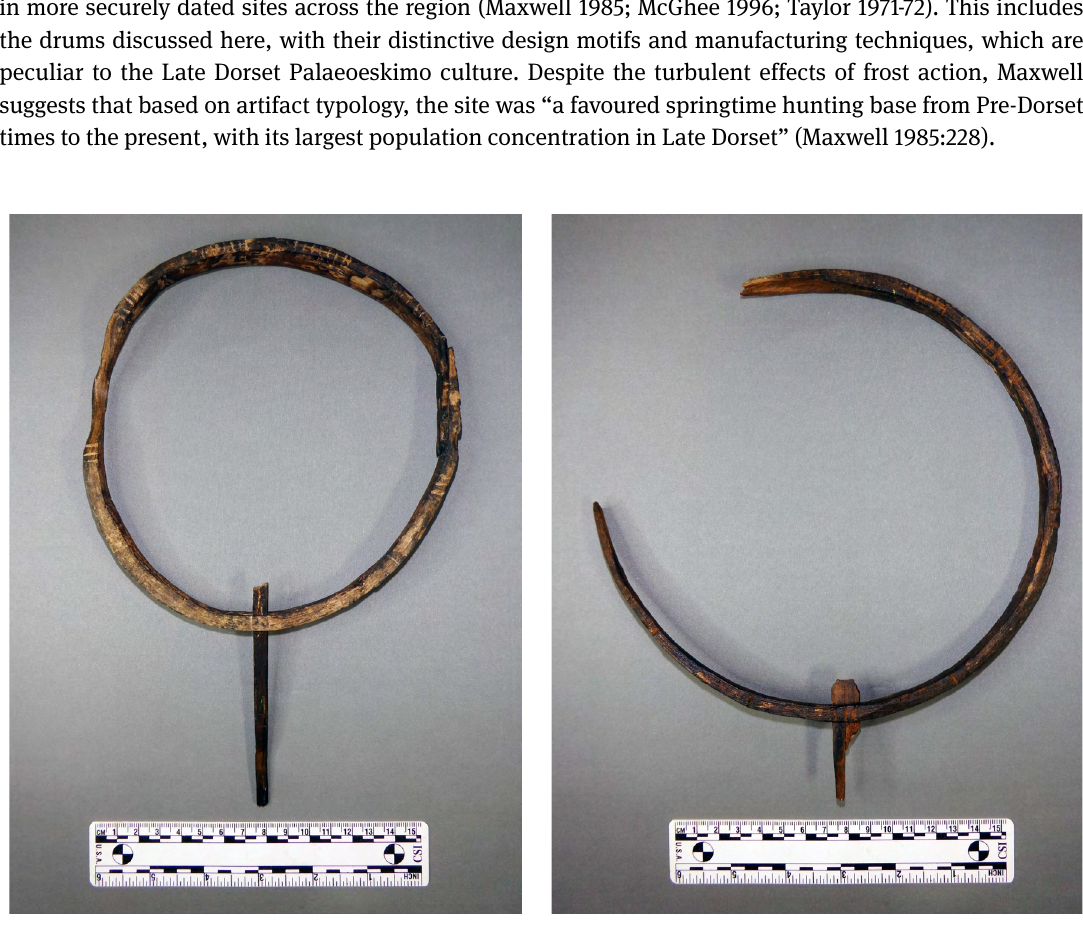
Figure 2. Button Point driftwood drum frame (PfFm-01:1750). Figure 3. Button Point driftwood drum frame (PfFm-01:1749). This frame is complete and the gap between the two scarfed ends is the result of taphonomic processes. Sets of Incised lines are visible on this frame as well. Photo by Tim Rast. Canadian Museum of